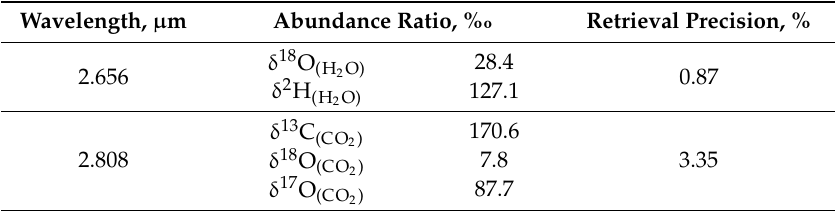
Table 2. Comparison of the isotopologue abundance ratio and retrieval precision of the